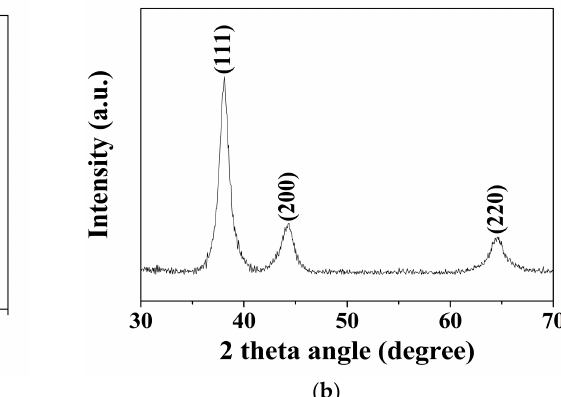
Figure 4. ( a ) The dependence of the size of the spherical gold nanoparticle on the growth/seed ratio; ( b ) XRD pattern of the gold nanoparticles prepared at a growth/seed ratio of 8:1.